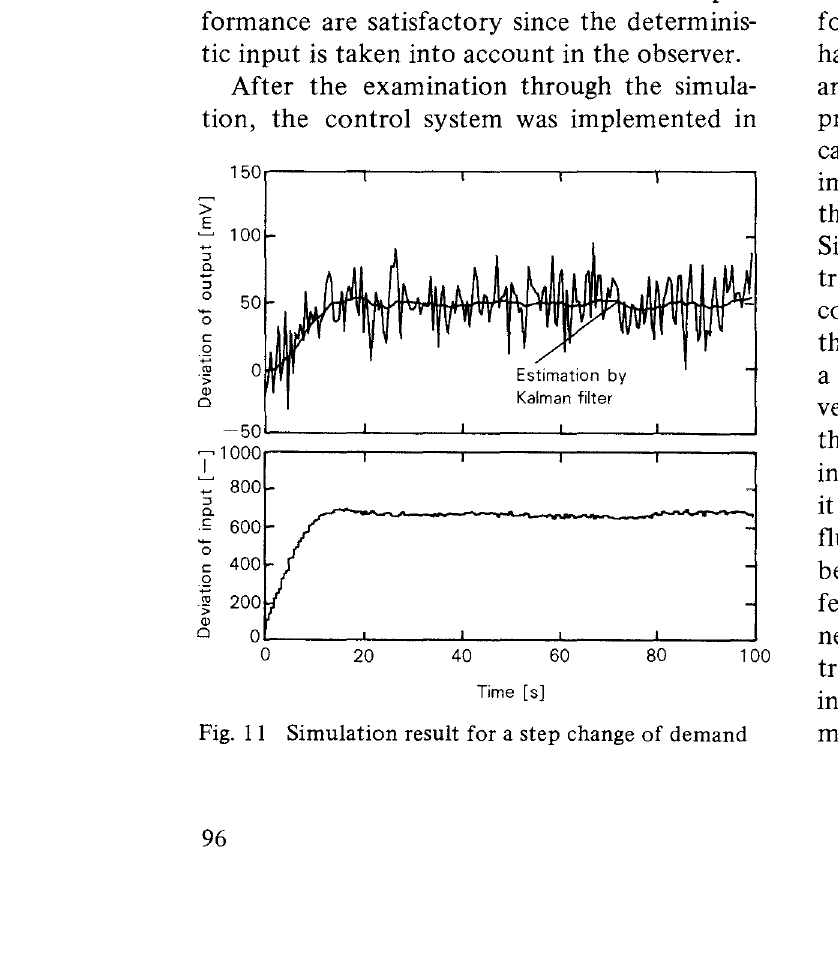
Fig. 12 Control performance for the experimental system (for a step change of